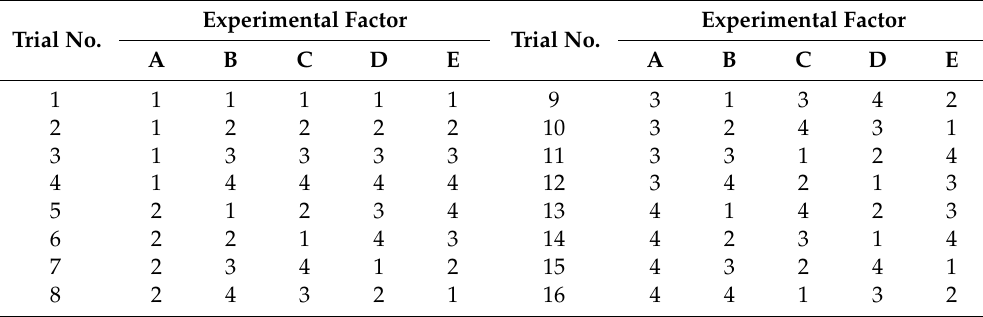
Table 7. Orthogonal array experimental